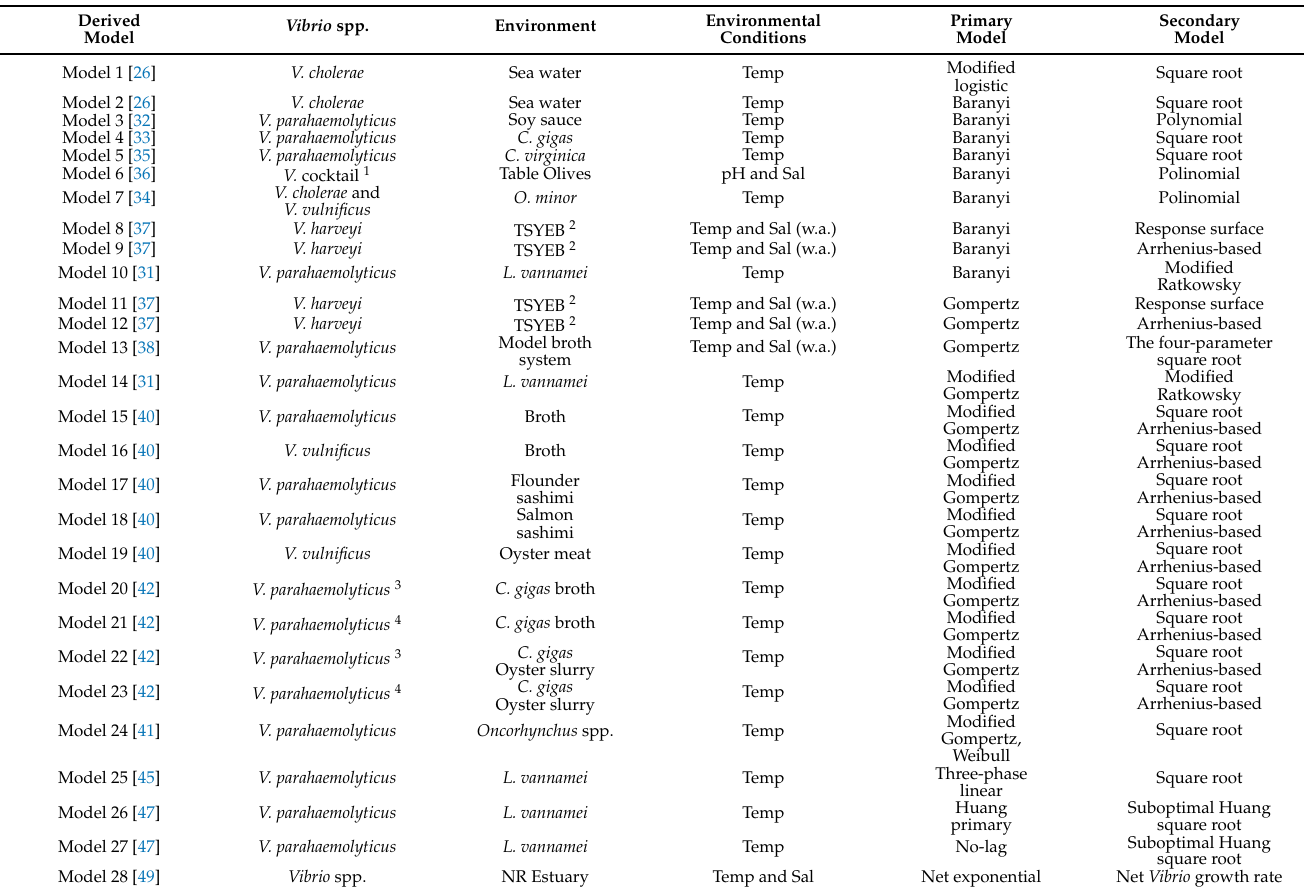
Table 4. List of models used in the analysis. For each model, Vibrio spp. is specified along with the environment where the growth of the organism was observed. The primary model defines growth function and the secondary model describes functional dependencies accounting for environmental conditions (temperature, salinity, and pH). “Temp” stands for temperature, “Sal” for salinity repre- sented in models as the concentration of NaCl (% NaCl), and “Sal (w.a.)” stands for water activity calculated from salinity. In simulations, salinity from datasets was converted to water activity when